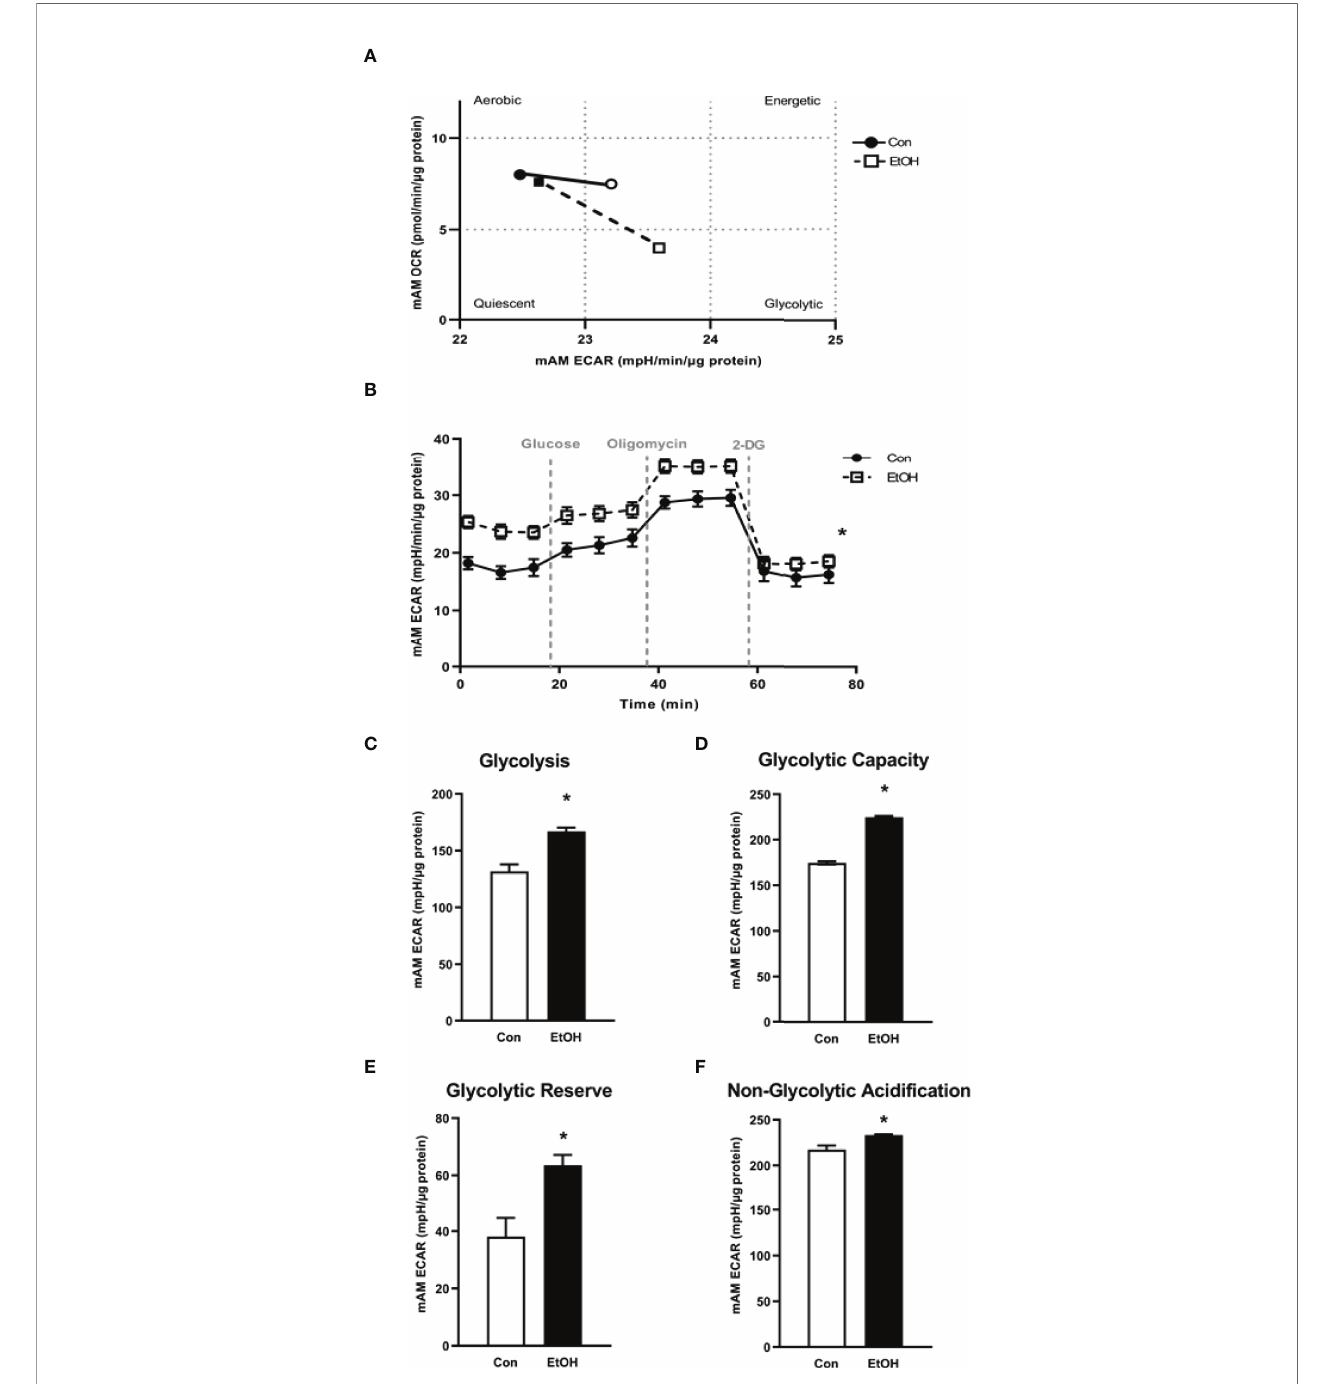
FIGURE 1 | EtOH induces glycolysis in mAM. Mouse alveolar macrophages (mAM) were isolated from mice fed either control (Con) or ethanol (EtOH; 20% v/w in drinking water, 12 weeks). (A) Oxygen consumption rates (OCR) and extracellular acidi fi cation rates (ECAR) were measured in response to an injection mixture of oligomycin (oligo; mitochondrial complex V inhibitor) and carbonilcyanide p-tri fl ouromethoxyphenylhydrazone (FCCP; ATP synthase inhibitor and proton uncoupler) using an extracellular fl ux analyzer. Cell energy phenotype was measured, normalized to protein levels, and are expressed as mean ± SEM (n = 4-5). ECAR were measured in response to sequential injections of glucose (saturating concentration of glucose to promote glycolysis), oligomycin (ATP synthase inhibitor), and 2- deoxy-glucose (2-DG; a glucose analog that inhibits glycolysis) using an extracellular fl ux analyzer. OCR measures are pmol over time and ECAR measures are mpH over time, normalized to total protein in the same sample well, and are expressed as mean ± SEM. Parameters of glycolytic function (B) , glycolysis (C) , glycolytic capacity (D) , glycolytic reserve (E) , and non-glycolytic acidi fi cation (F) are expressed as mean ± SEM, relative to control (n = 12-14). * p < 0.05 verses